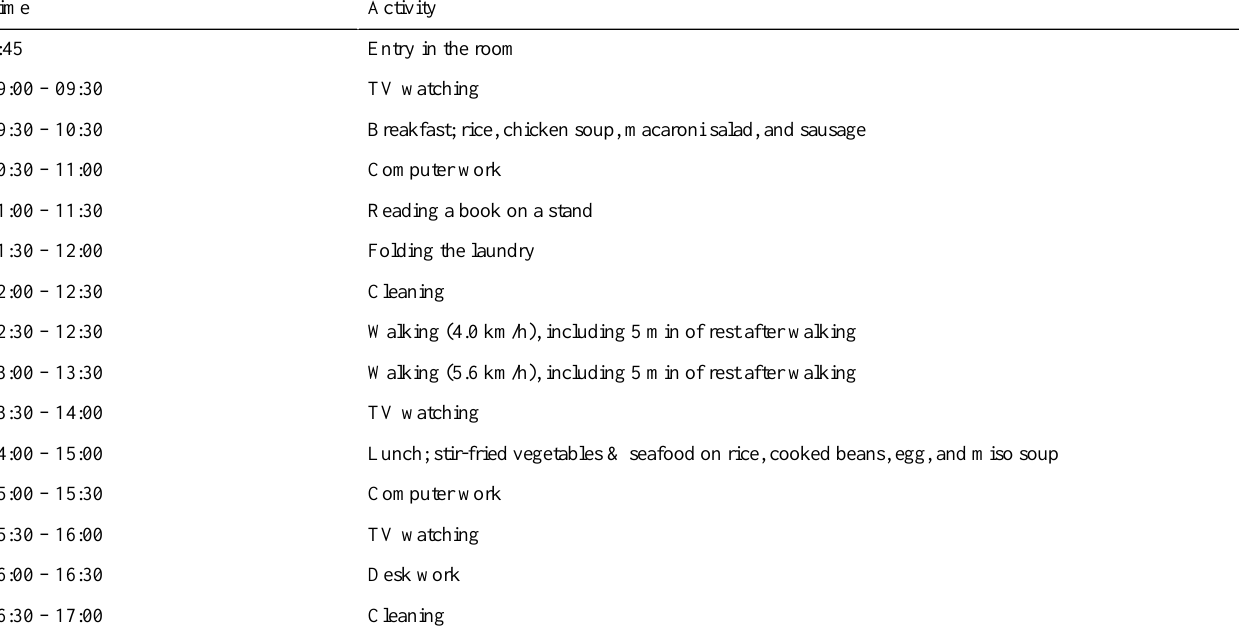
Table 2. Timetable for metabolic chamber on a standardized day.